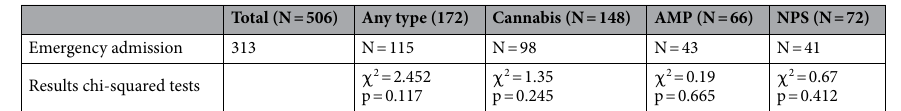
Table 4. Taking illicit substances according to the admission